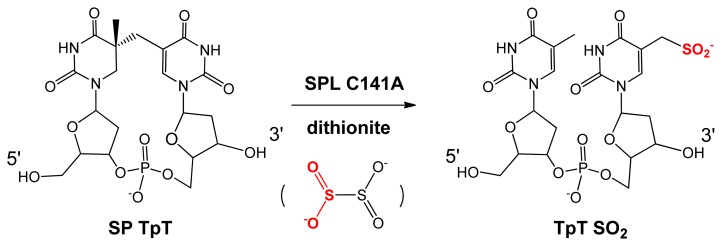
Formation of TpTSO2− after SP TpT repair by the B. subtilis SPL 141A mutant.